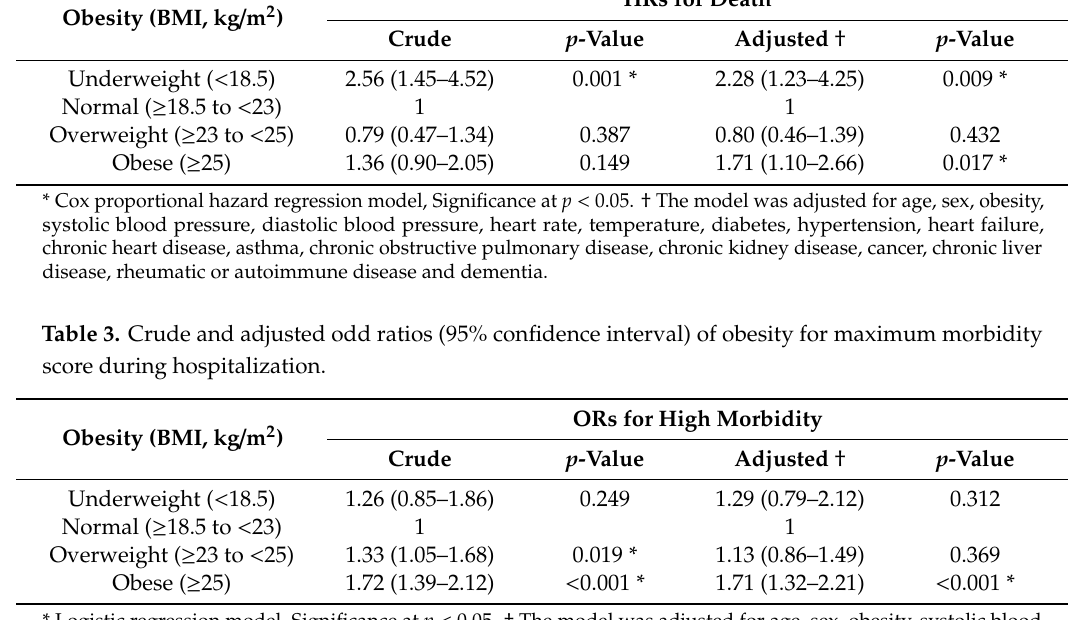
Table 2. Crude and adjusted hazard ratios (95% confidence interval) of obesity for mortality. Obesity (BMI, kg / m 2 ) Underweight ( < 18.5)